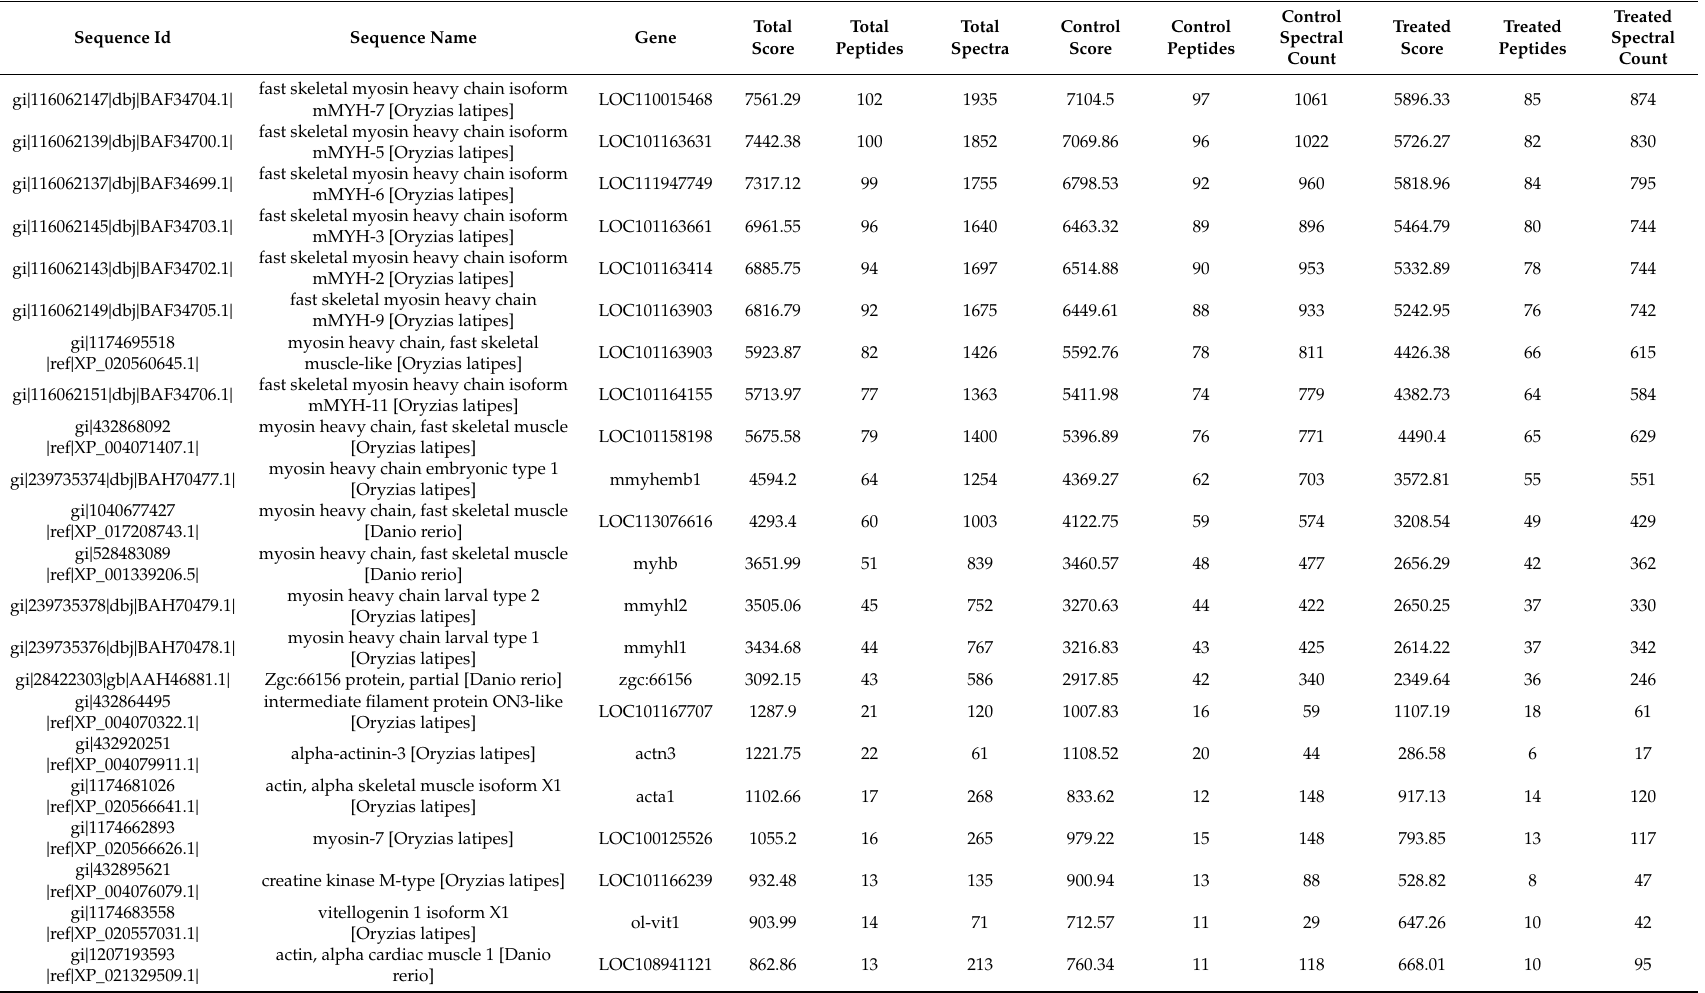
Table 1. Example of the outcome after the ProteoIQ filtering presenting the data for the top 30 proteins identified in